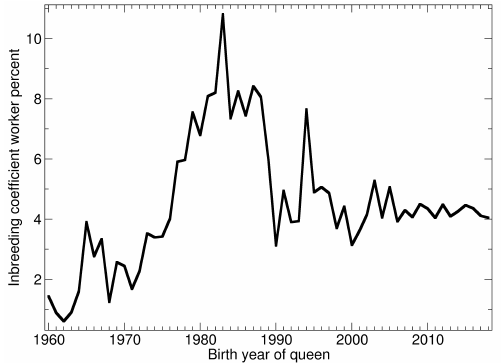
Figure 9. Average inbreeding coefficient of the workers by